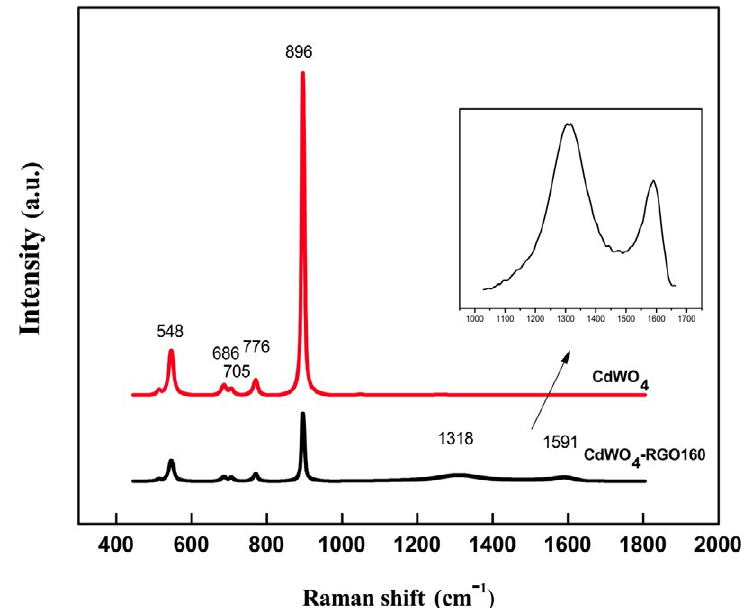
Fig. 6. Raman spectra of (a) the pure CdWO